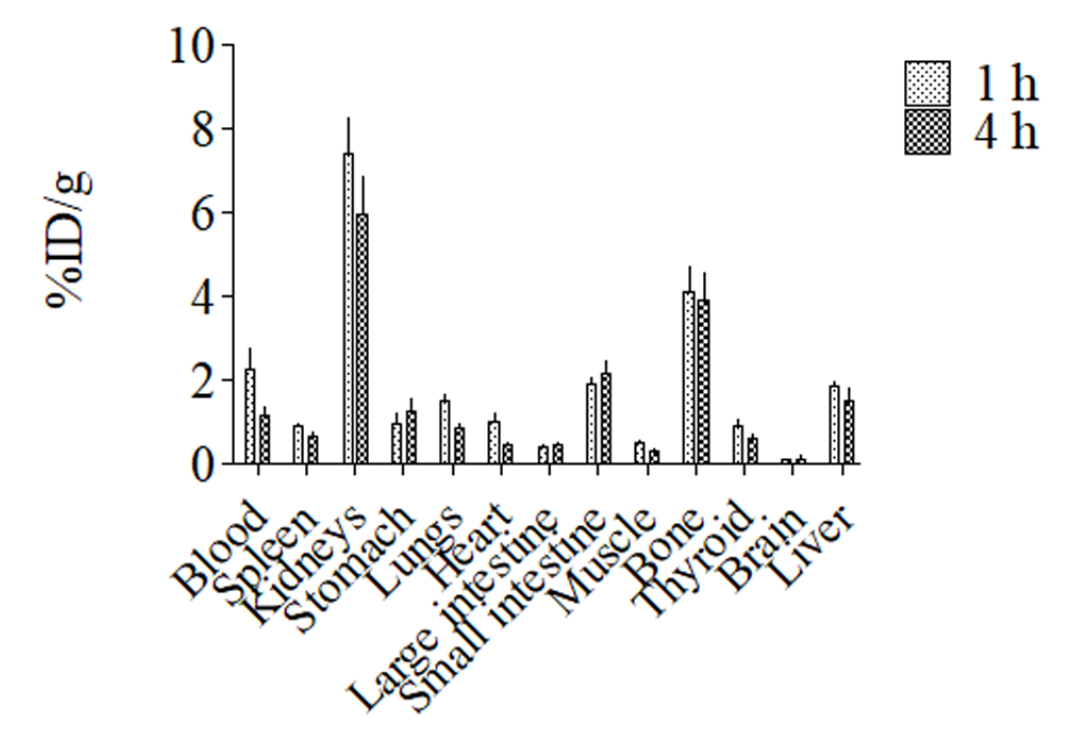
FIGURE 5 - Biodistribution profile of 99m Tc-CDV following intravenous tail-vein administration in healthy female SWISS mice. All data are the mean percentage (n=7) of the injected dose of 99m Tc-CDV per gram of tissue ± SD of the